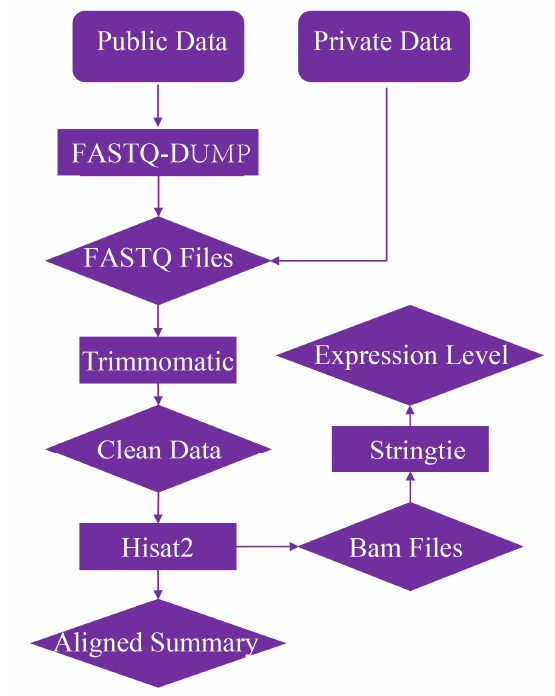
Figure 1. The standard pipeline of the treatment of public and private RNA-seq data.